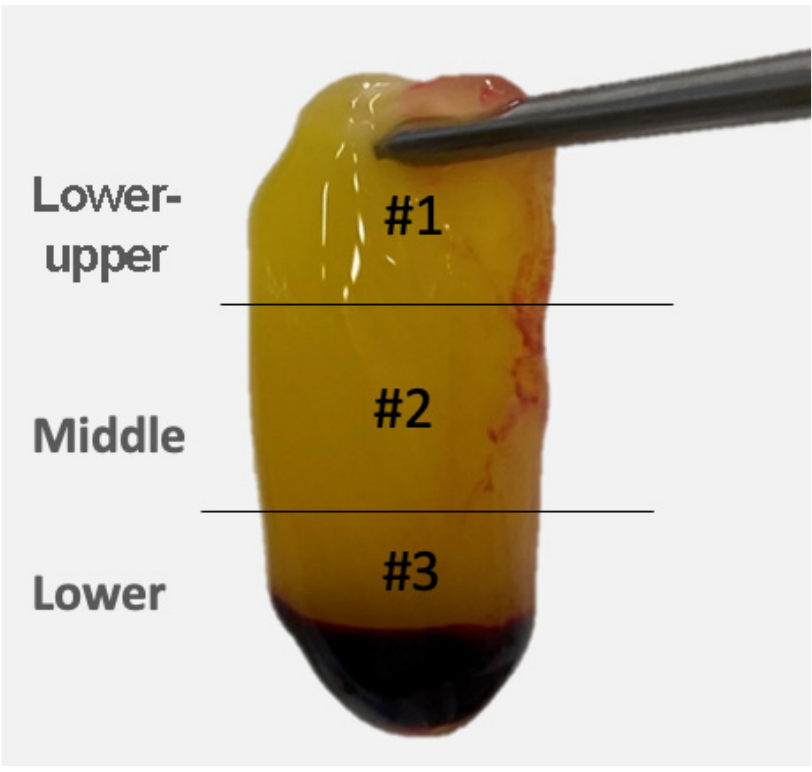
Figure 2. PRF membrane . #1. Lower-upper portion. #2. Middle portion. #3. Lower portion. Each sample was fixed with 2.5% neutralized glutaraldehyde (2 h, 4 °C) (Figure 3A),